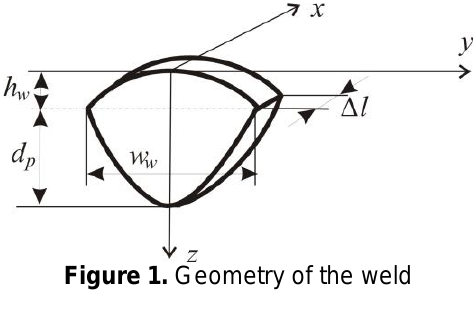
Figure 1. Geometry of the weld